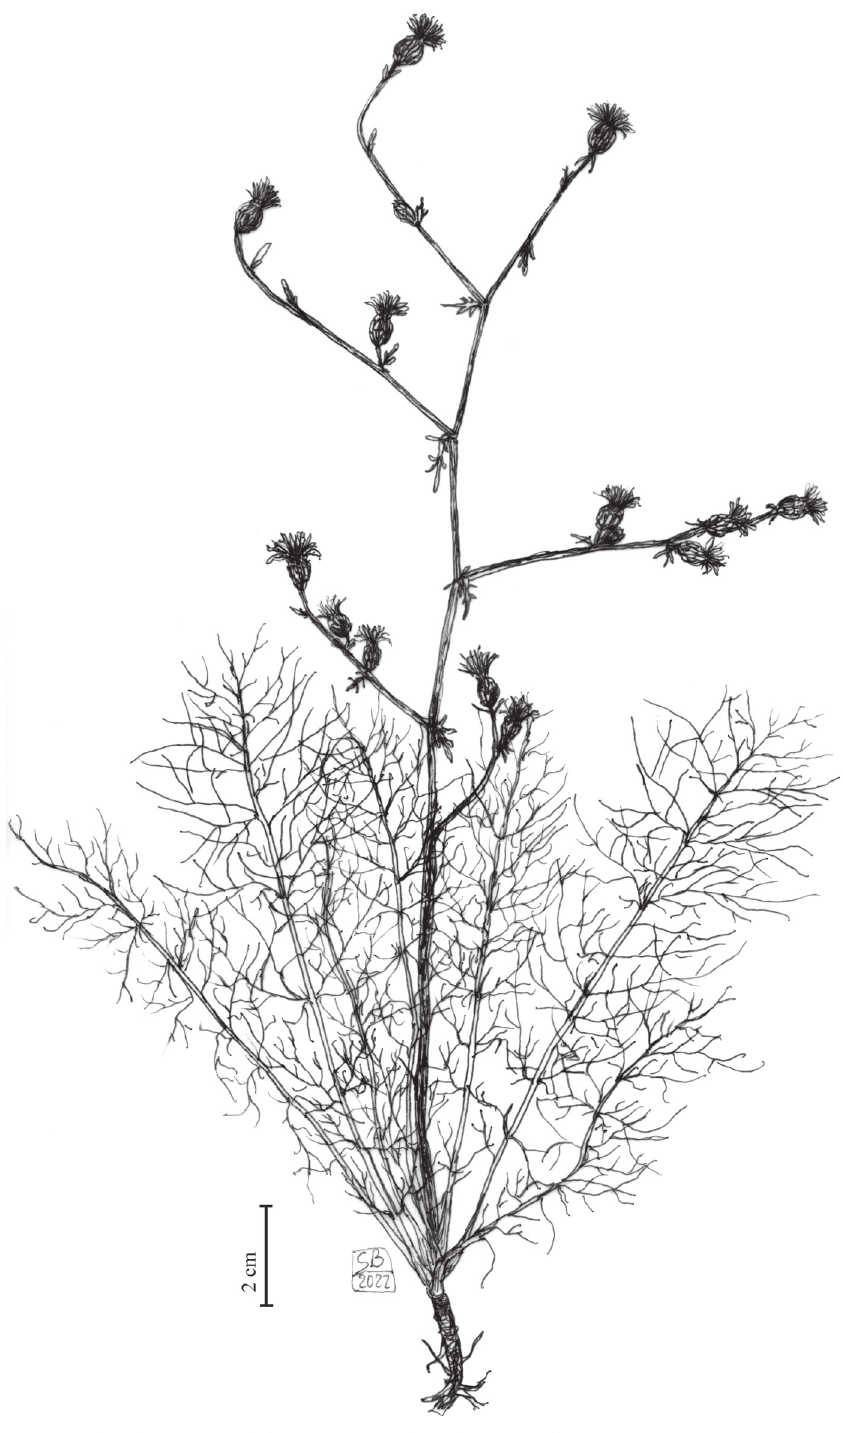
Figure 5. Habit of Centaurea glaberrima . Drawn by Salvatore